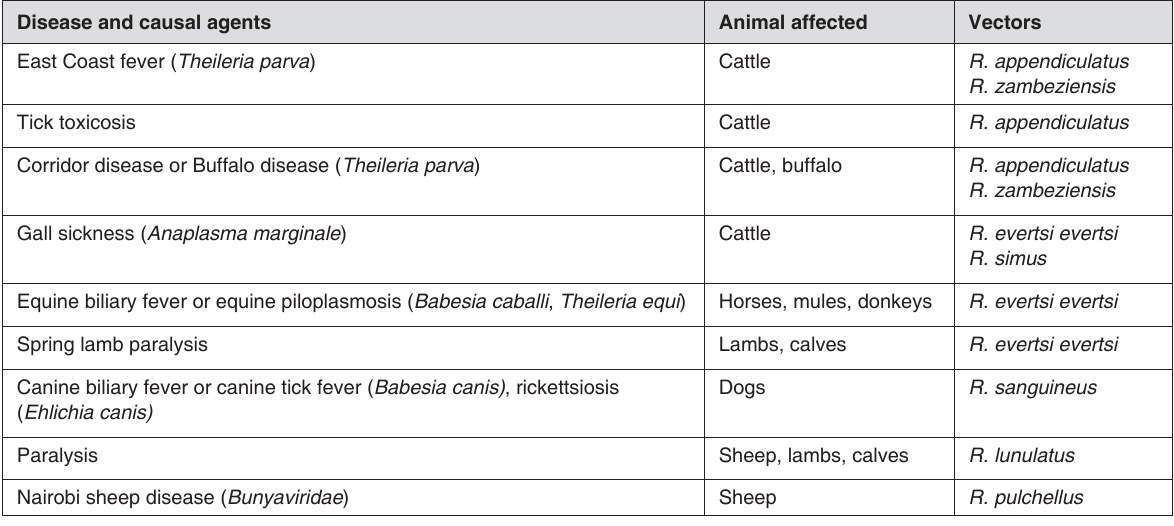
TABLE 1 Rhipicephalus spp. and the diseases with which they or the toxins they produce are associated Disease and causal agents